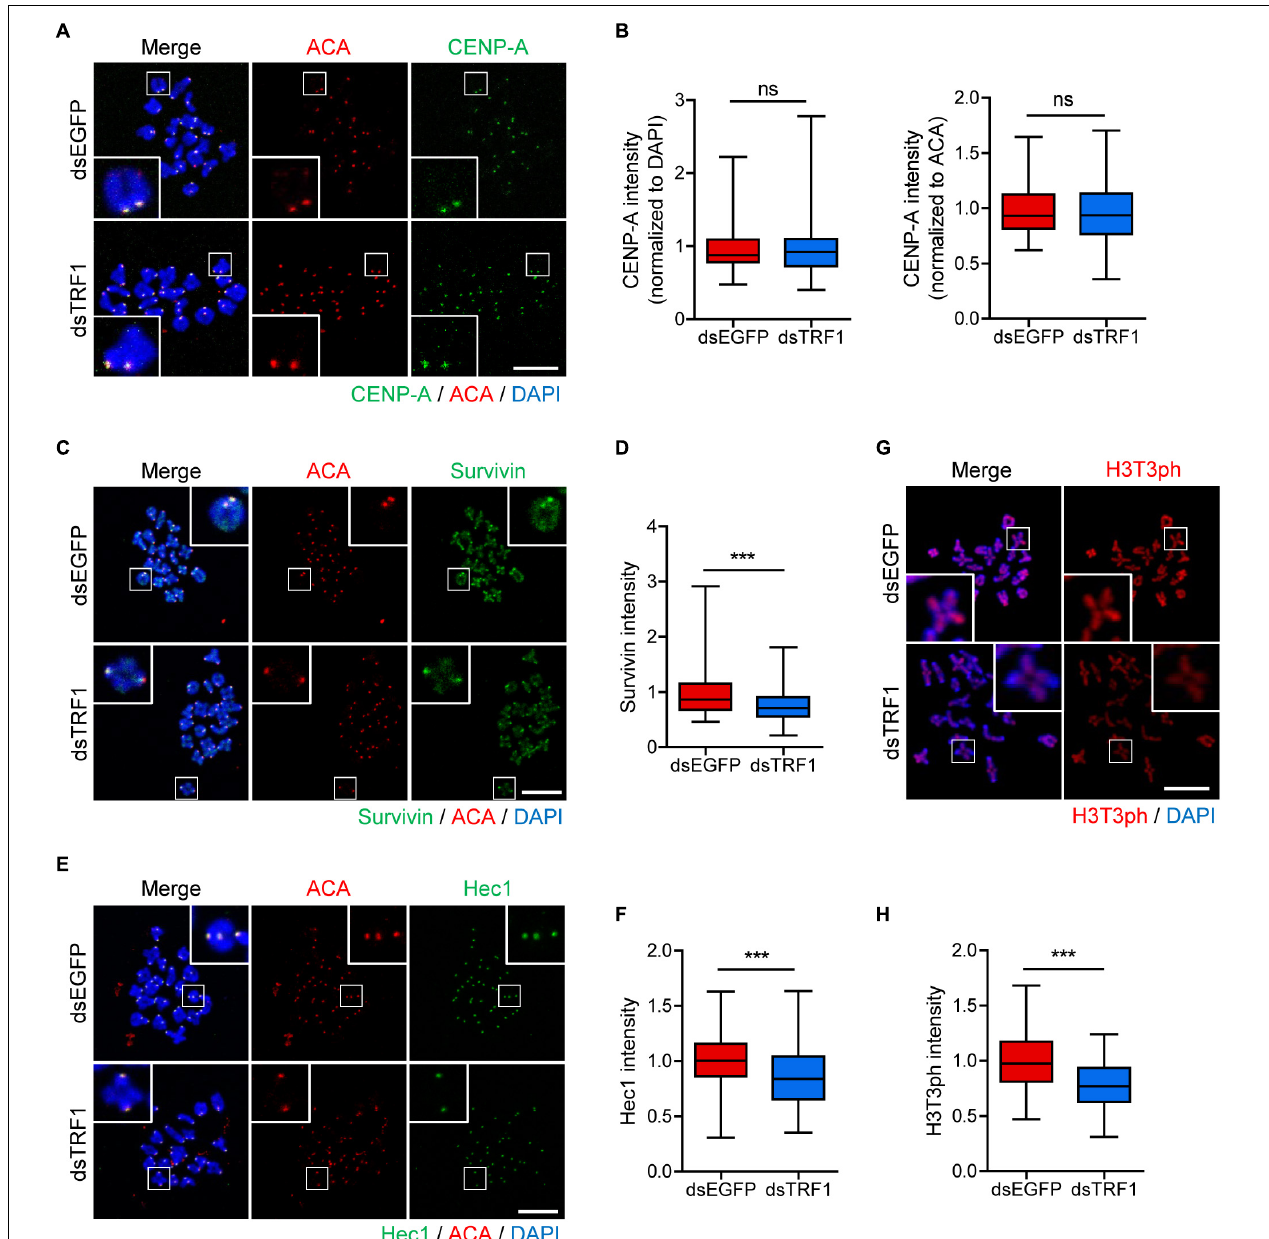
FIGURE 3 | TRF1 is required to maintain inner centromere and kinetochore integrity. Chromosome spreads were prepared from oocytes at the MI stage and were stained with anti-CENP-A, anti-Survivin, anti-Hec1, and anti-H3T3ph antibodies. Kinetochores and DNA were labeled with anti-centromere antibody (ACA) and DAPI, respectively (scale bar, 20 µ m). (A–H) The intensities of CENP-A (normalized to DAPI or ACA), Survivin, and Hec1 were quantified, also shown in representative images. ns; not significant, *** p <